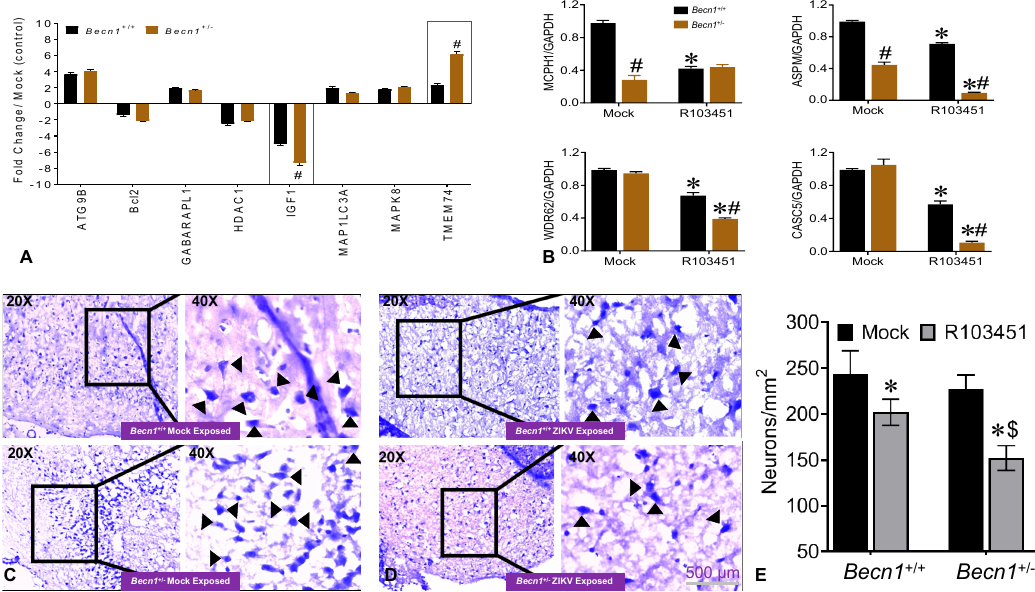
Figure 3. Reduced expression of growth factor, microcephaly-associated genes and neuronal loss in brain of pups exposed in-utero to ZIKV. ( A ) Half of the brain tissues were minced and used to measure autophagy related genes and growth factors in Becn1 +/+ (black bar) and Becn1 +/ − (brown bar) pups exposed to ZIKV in utero, by RT-PCR. The results are expressed as fold change from respective (mock) control (increase or decrease). ( B ) RNA expression of the microcephaly genes, microcephalin-1 (MCPH1), abnormal spindle like primary microcephaly (ASPM), WD repeat containing protein 62 (WDR62), and cancer susceptibility candidate 5 (CASC5) were measured by RT-PCR in brain of Becn1 +/+ (black bar) and Becn1 +/ − (brown bar) pups exposed to mock and ZIKV in utero. Expression levels are relative to Becn1 +/+ pups born from wild-type mice and normalized to Glyceraldehyde 3-phosphate dehydrogenase (GAPDH). ( A , B ) The error bars show the mean ± SEM of three experiments with N = 21 for Becn1 +/+ and N = 19 for Becn1 +/ − pups. The data were analyzed by two-way ANOVA followed by Tukey’s multiple comparison test. * p < 0.05 vs. respective mock infected strain, # p < 0.05